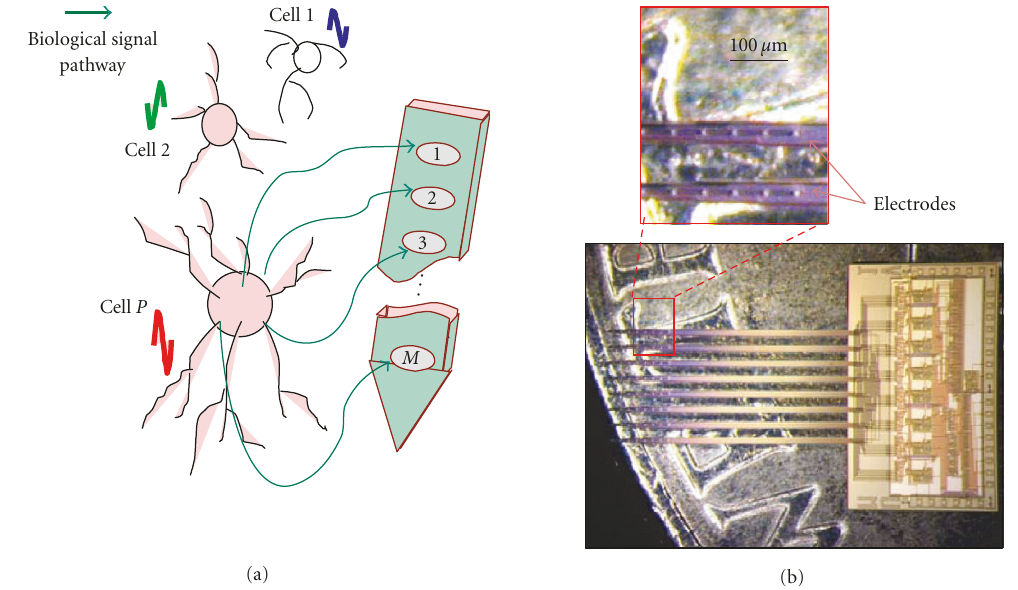
Figure 2: (a) Schematic of a microprobe array of M electrodes monitoring neural activity from P adjacent neural cells in the central nervous system. (b) A 64-channel Michigan electrode array with integrated electronics (amplification and bandpass filtering) on the back side of a US 1 cent